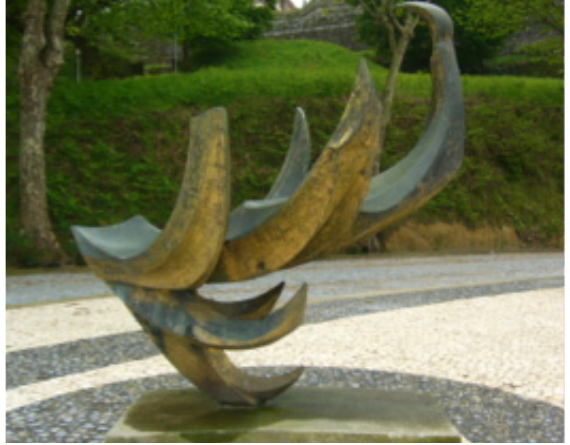
FIGURE 12 | A. Rocha, Spring Rhythms, 1961